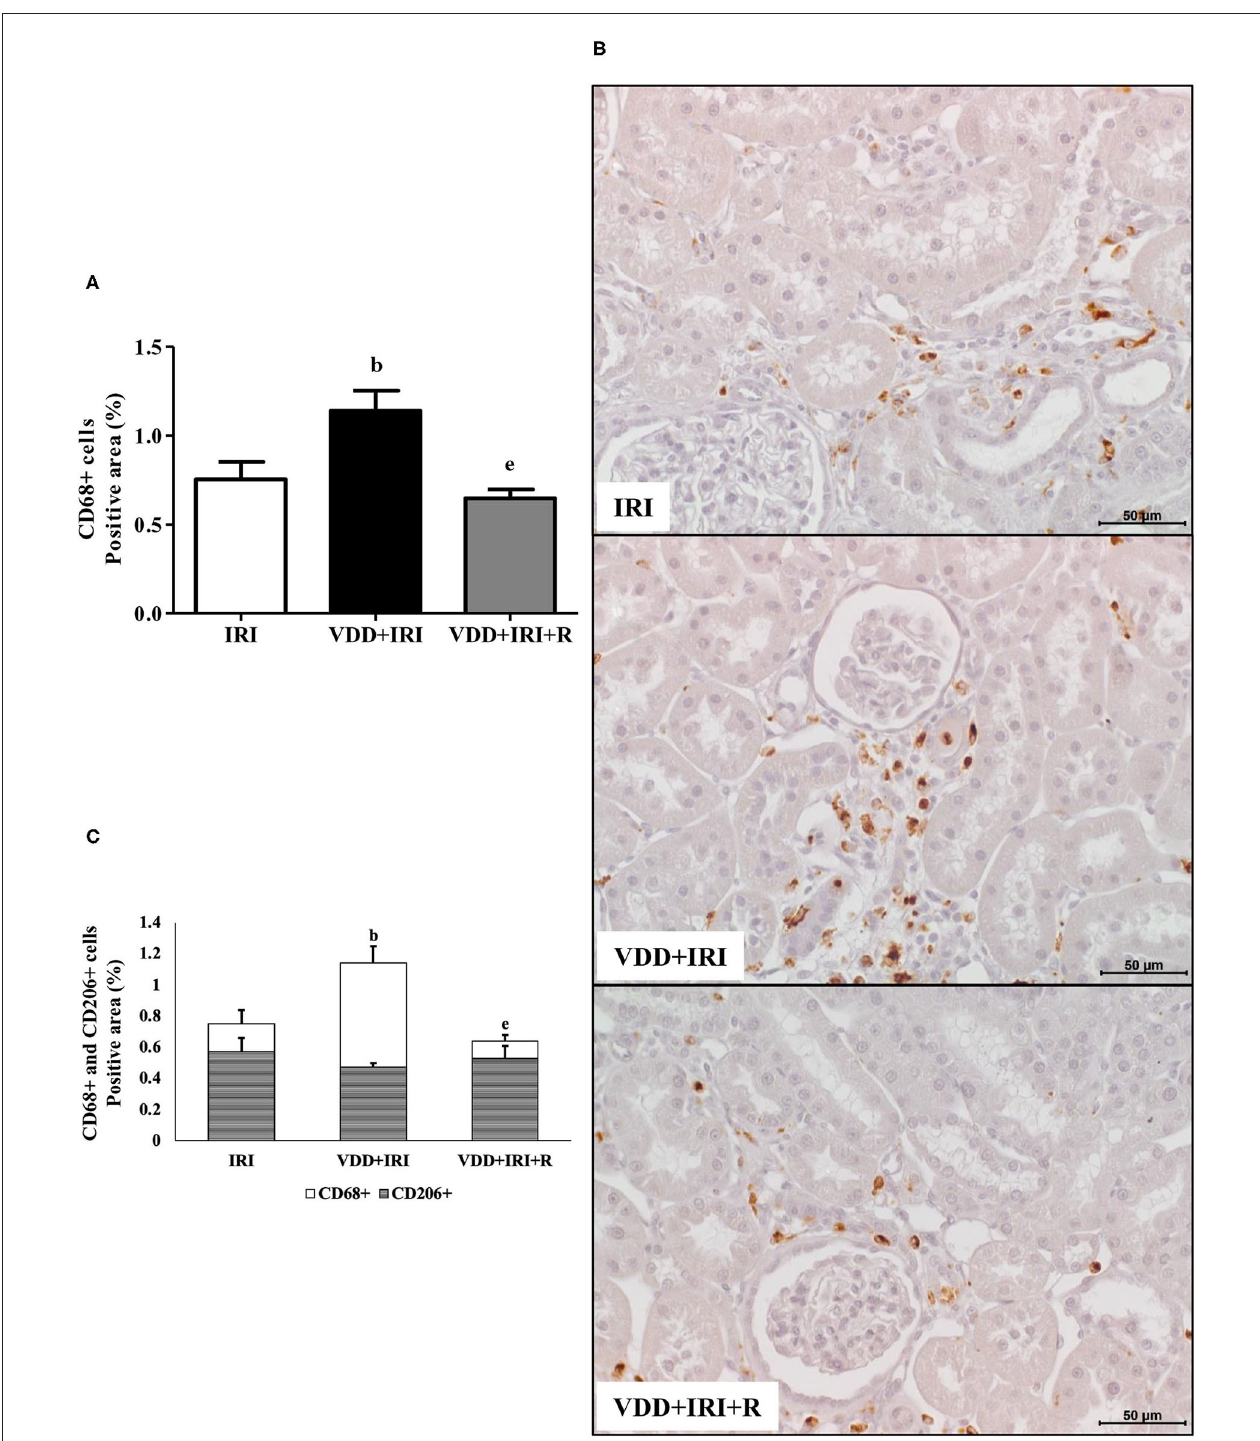
FIGURE 4 | Immunohistochemical analysis of CD68 + cells (M1 + M2 macrophages) and CD206 + cells (M2 macrophages) expression in the kidney tissue evaluated 90 days after ischemia/reperfusion insult (IRI) on day 30. (A) Bar graph of CD68 + cells expression values. (B) Representative photomicrographs of immunostaining for CD68 + cells in the renal cortex from an IRI, VDD + IRI and VDD + IRI + R rat ( × 400). Note that vitamin D replacement restored the expression of CD68 + cells in the VDD + IRI + R rats. (C) Bar graph regarding the proportion of CD206 + cells in relation to the amount of CD68 + cells. Data are mean ± SEM. b p < 0.01, vs. IRI; e p < 0.01 vs. VDD + IRI. VDD, vitamin D deficiency; R, vitamin D replacement. Diet protocol: IRI, standard diet for 120 days; VDD + IRI, vitamin D-free diet for 120 days; and VDD + IRI + R, vitamin D-free diet in the first 30 days and standard diet in the last 90 days.